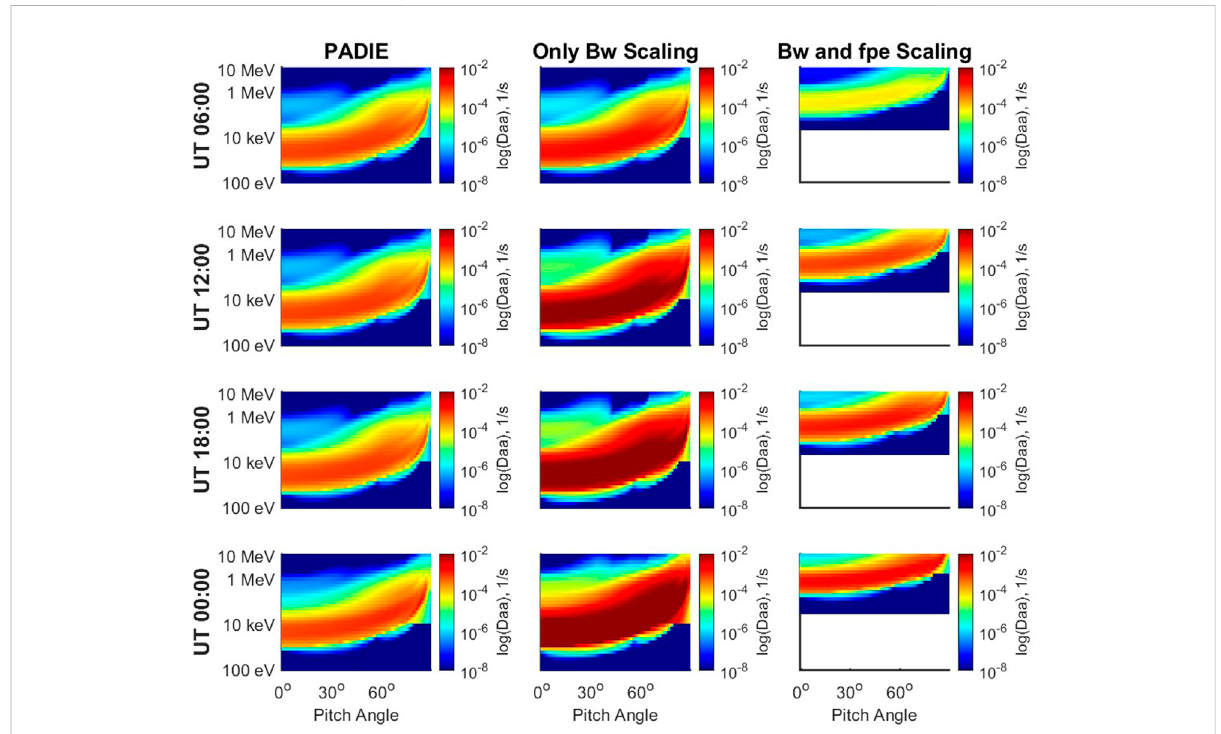
FIGURE 5 Pitch angle diffusion coef fi cients D αα at various times on March 17-18, 2013, for L = 6 and MLT range of 0:00-03:00. The diffusion coef fi cients computed from PADIE (Section 2.2) are shown in the left column and use statistical models of the plasma density and chorus intensity. The middle column shows the diffusion coef fi cients scaled for only the chorus intensity B w using only the 30 – 100 keV energy range (Section 4.1). The right column shows the diffusion coef fi cients scaled for both B w and the plasma-gyrofrequency f pe / f ce (Section